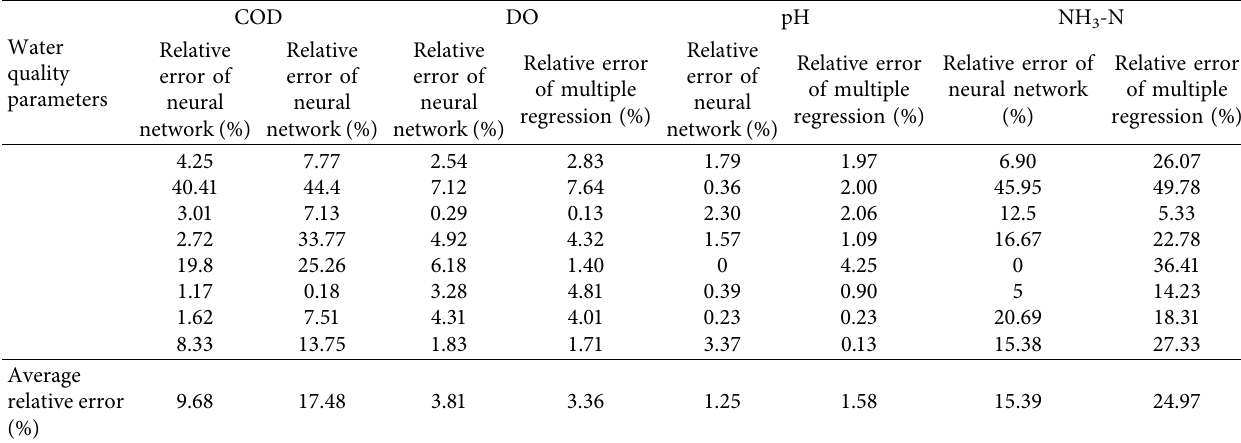
Table 10: Relative errors of different